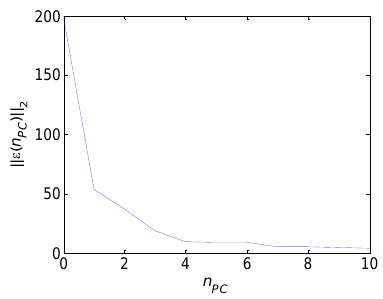
Figure 2. The curve of (cid:107)E ( n PC ) (cid:107)